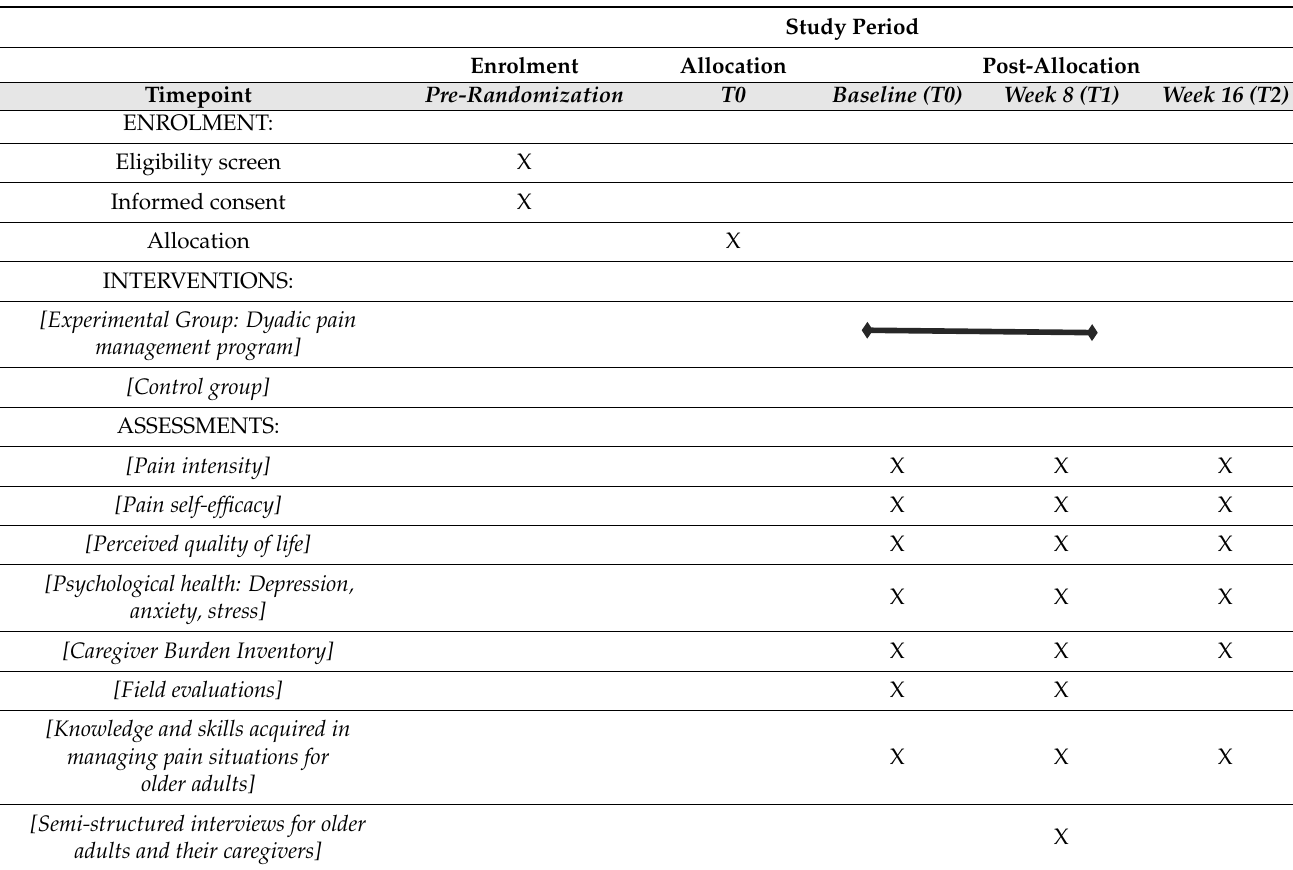
Table 1. Schedule of enrolment, interventions, and assessments of DPM.